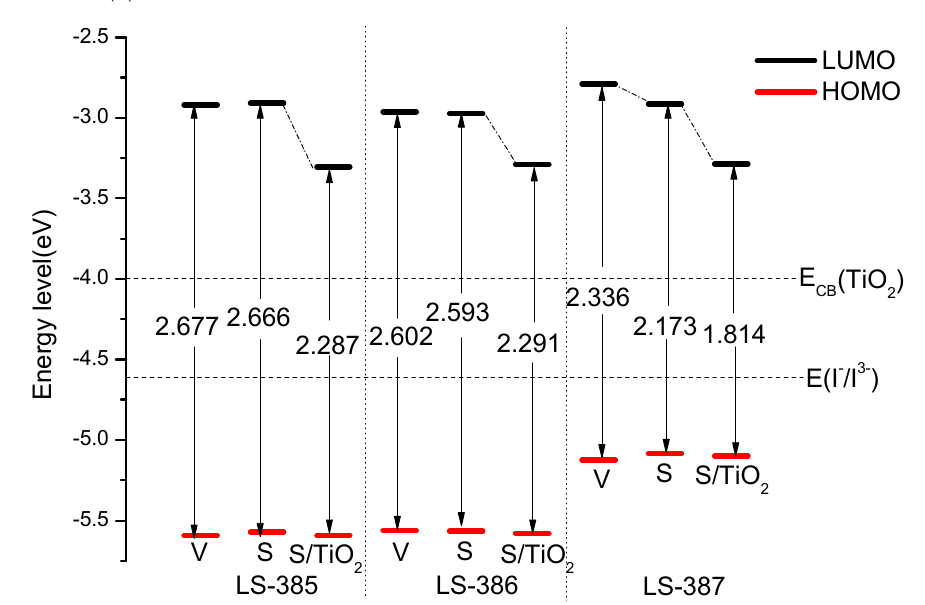
Figure 3. The molecules energy levels diagram of LS-385, LS-386, LS-387 (V, S, and S/TiO 2 representative in vacuum, in solvent and dyes/TiO 2 in solvent, respectively).